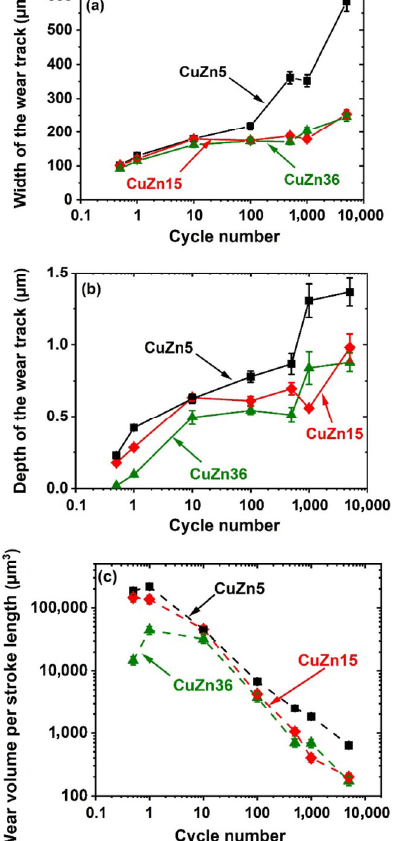
Fig. 2 (a) Width, (b) depth, and (c) wear volume for the wear tracks after non-lubricated reciprocating sliding of Si 3 N 4 spheres on  -brass samples with 5, 15, and 36 wt% zinc as a function of the cycle number for a total of 5,000 cycles. The width of the wear tracks was measured using optical and the depth by confocal